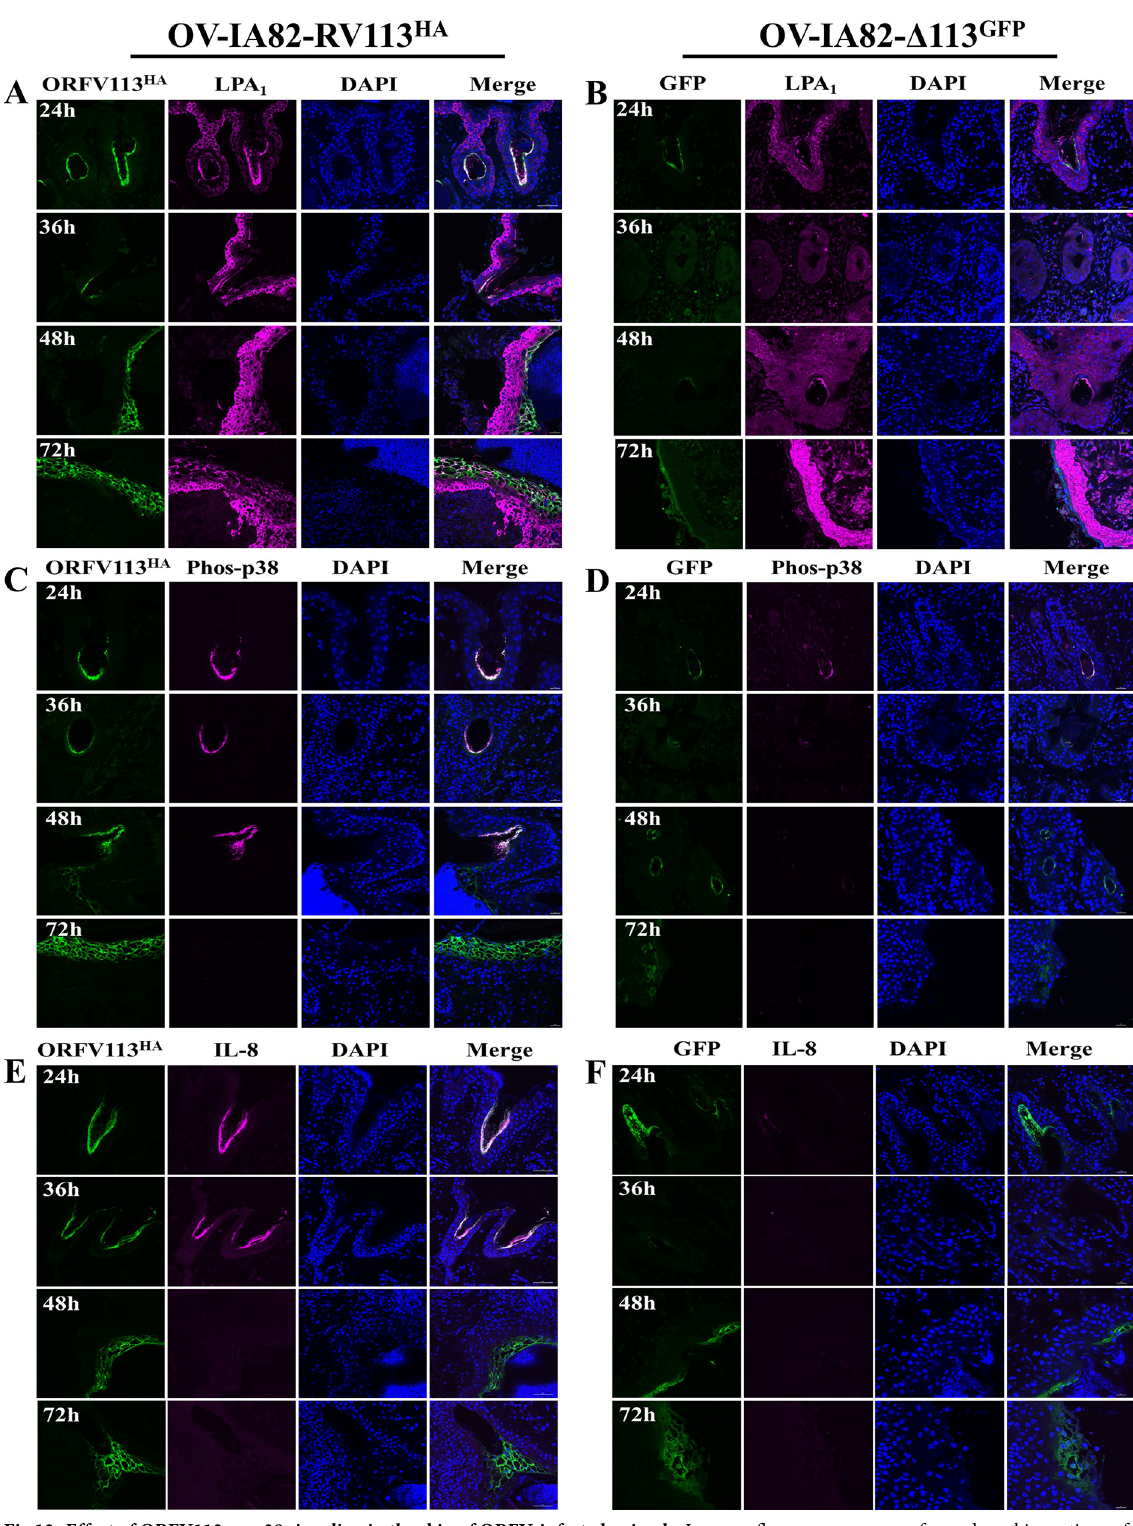
Fig 12. Effect of ORFV113 on p38 signaling in the skin of ORFV-infected animals. Immunofluorescence was performed on skin sections of animals infected with OV-IA82RV113 HA (RV113) or OV-IA82 Δ 113 GFP ( Δ 113), or mock infected at various times p.i as described in materials and methods. (A and B) LPA 1 Expression (A) RV113 and Δ 113 (B), Green: ORFV113 HA or GFP, Violet: LPA 1 , Blue: DAPI; (C and D) Level